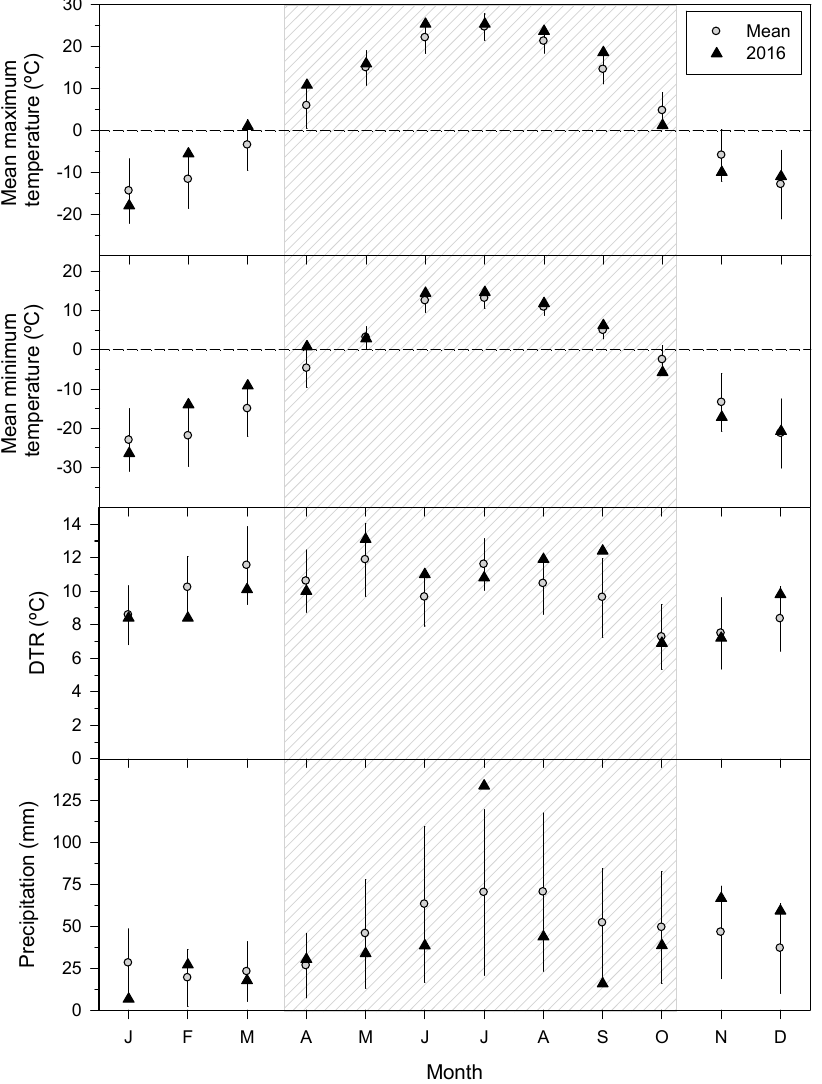
Figure 2. Monthly climate variables measured in 2016 (triangles), when the SSM outbreak started, as compared with mean values for the period 1950–2020 (excluding the year 2016). Error bars are 95% confidence intervals. The striped area indicates the months with maximum activity of SSM larvae. DTR is the diurnal thermal range. From 2000 to 2017, the NDII of the D1 site was significantly ( U = 73, p = 0.005) higher (mean NDII ± SE = 0.35 ± 0.01) than that of the ND (0.31 ± 0.01) and D2 sites (0.32 ± 0.01). In 2018, we detected a significant ( p < 0.001) regime shift index in the NDII series of the two defoliated stands corresponding to a sharp drop in NDII (Figure 3). From 2018 to 2021, the NDII of D1 (0.20 ± 0.01) and D2 (0.22 ± 0.01) sites was significantly ( U = 71, p = 0.03) lower than in the ND site (0.30 ± 0.01). In 2012, the NDII increased (the mean value across sites was 0.41), reaching the maximum value of the period 2000–2021 at each site.